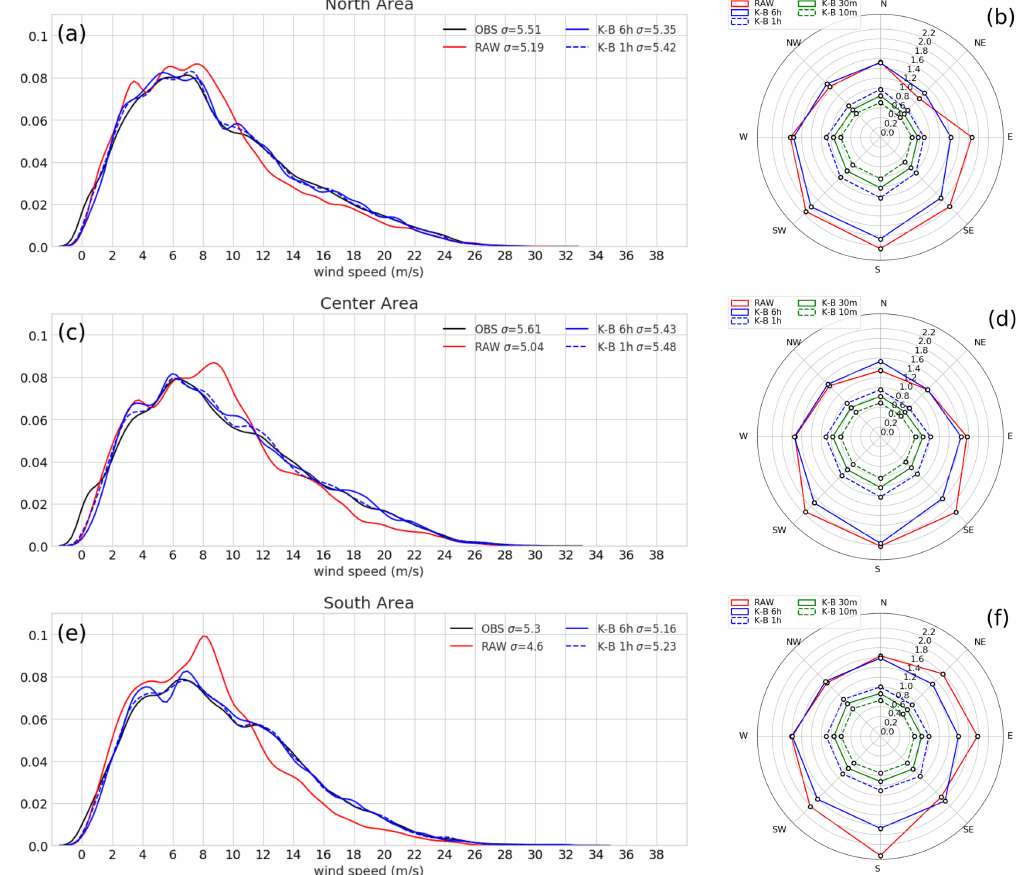
Figure 3. ( a ) Wind speed distribution plot for observations, RAW, K-B 6 h and K-B 1 h time experiments in the north area of the wind farm. The standard deviation of each distribution is indicated in the legend. ( b ) Radar charts comparing WS errors by observed wind direction in the north area. ( c ) Same as ( a ) for the center area. ( d ) Same as ( b ) for the center area. ( e ) Same as ( a ) for the south area. ( f ) Same as ( b ) for the southern area.